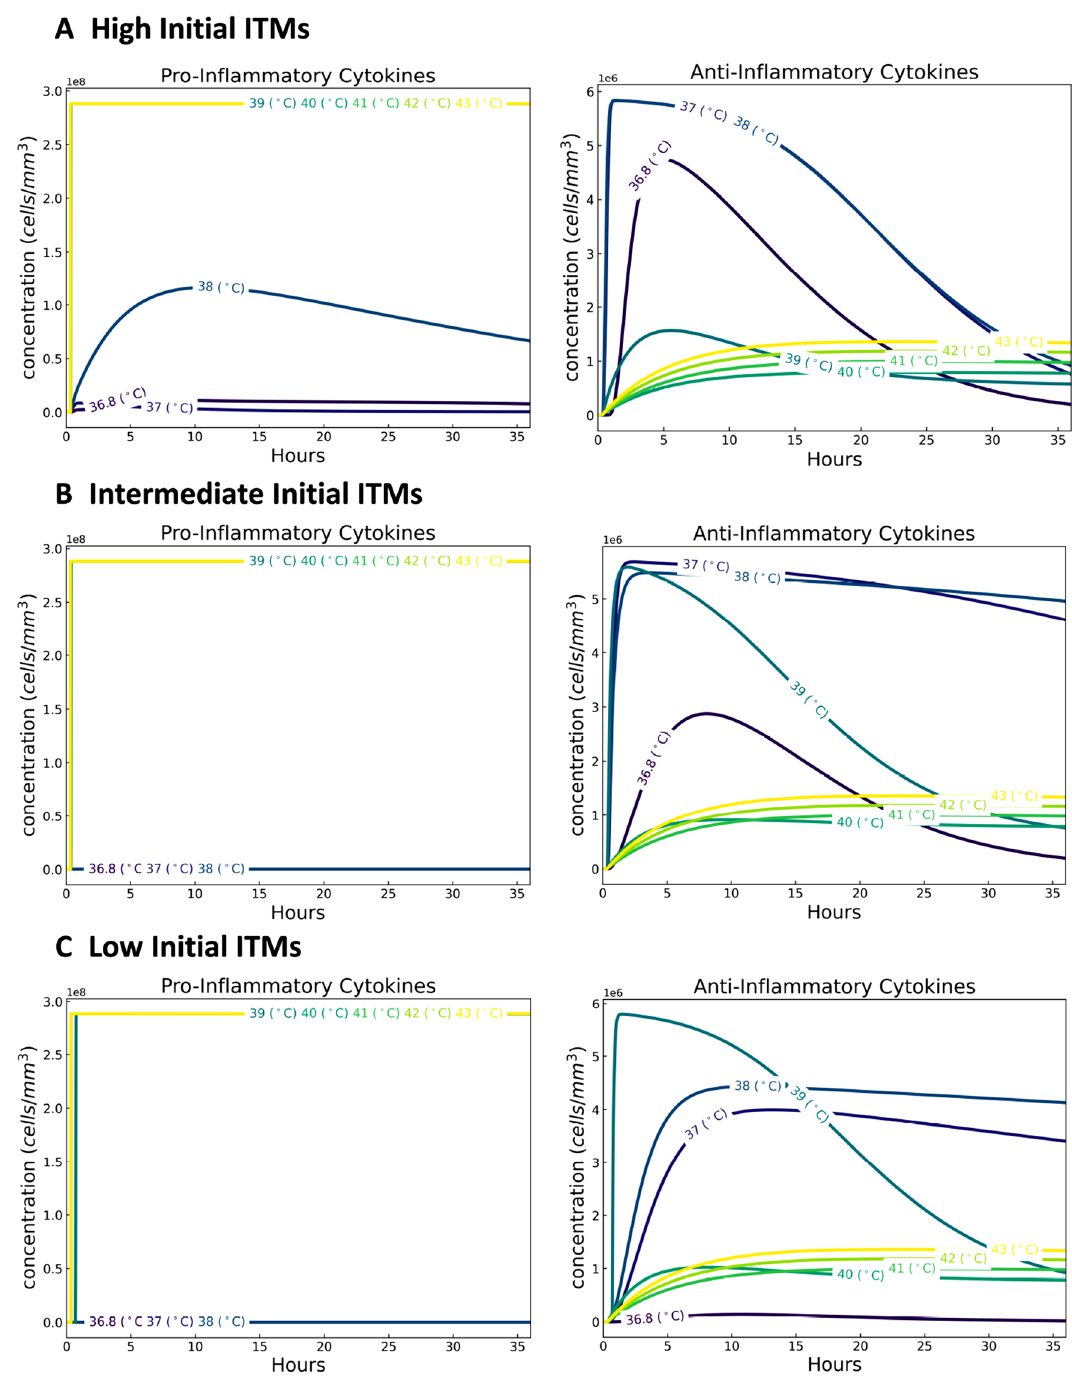
Figure 3. Dynamics of cytokines for a temperature-dependent human innate immune system. The shift in dynamics of cytokines in the mild febrile range (37, 38] ◦ C for anti-inflammatory cytokines is seen more prominently in high initial ITMs. Pro-inflammatory cytokines, on the other hand, are generated in low concentrations for temperatures within the mild febrile